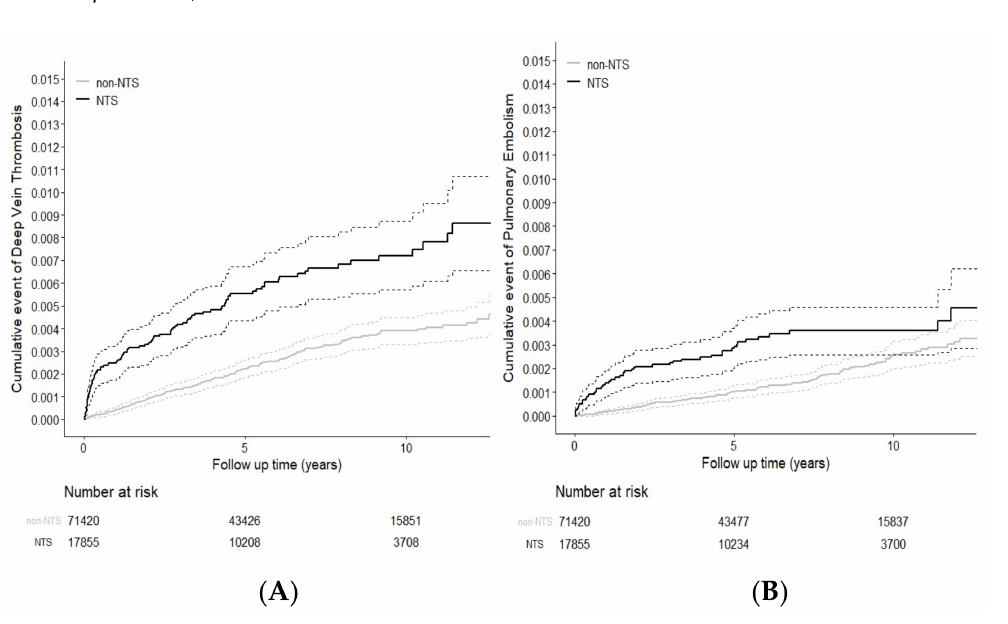
Figure 1. Cumulative incidence competing risk (death) for deep vein thrombosis (DVT) ( A ) and pulmonary embolism (PE) ( B ) among patients with and without